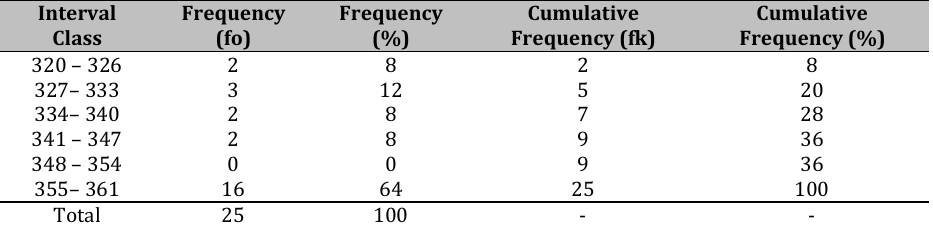
Table 3 Frequency Distribution of Teachers’ Performance Using Academic Supervision Guidebook